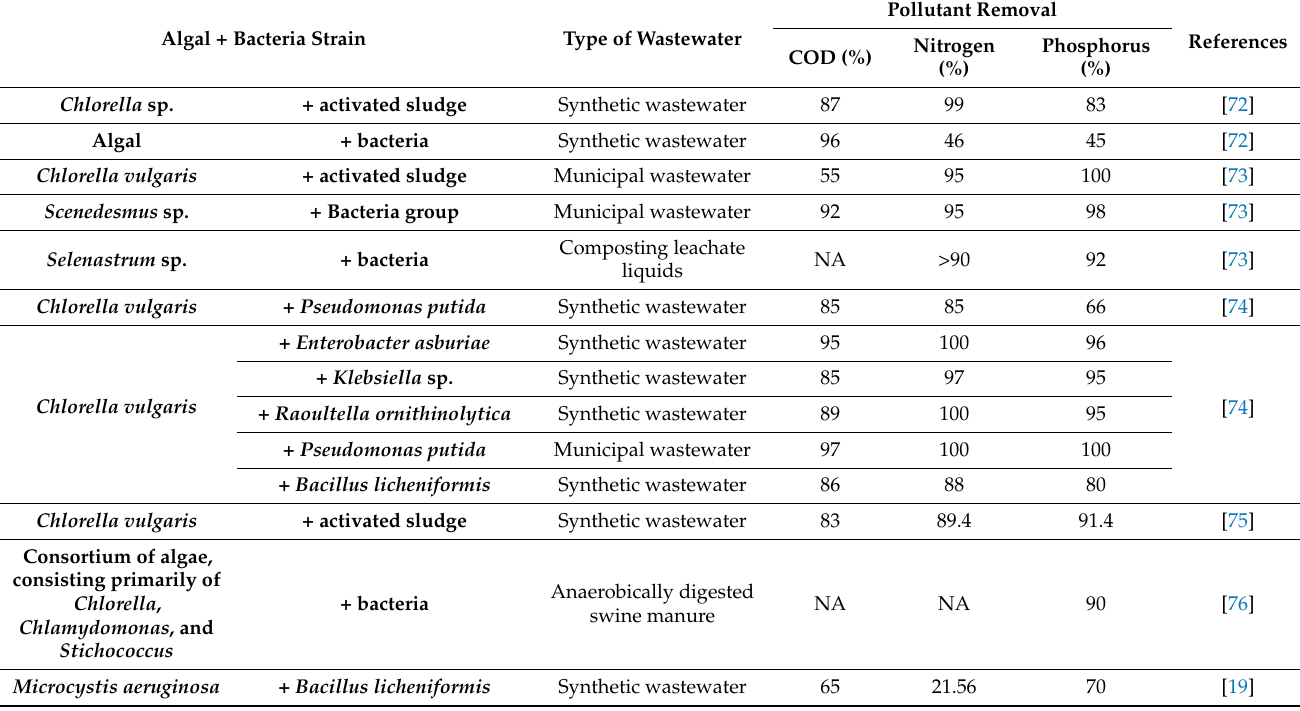
Table 2. Different consortia of algal bacteria used in wastewater